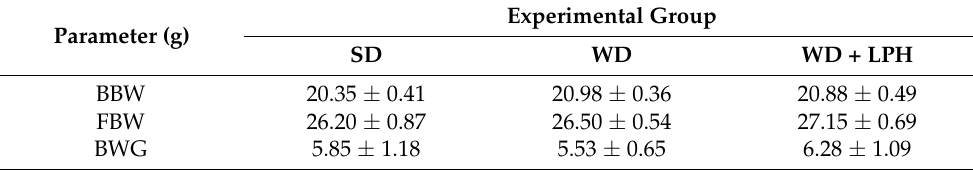
Table 3. Body weight